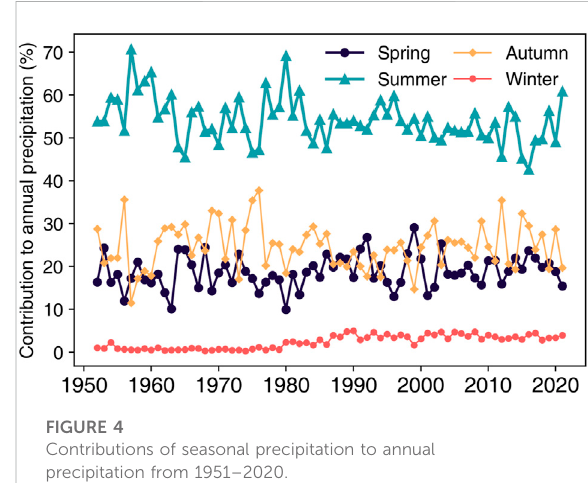
FIGURE 4 Contributions of seasonal precipitation to annual precipitation from 1951 –